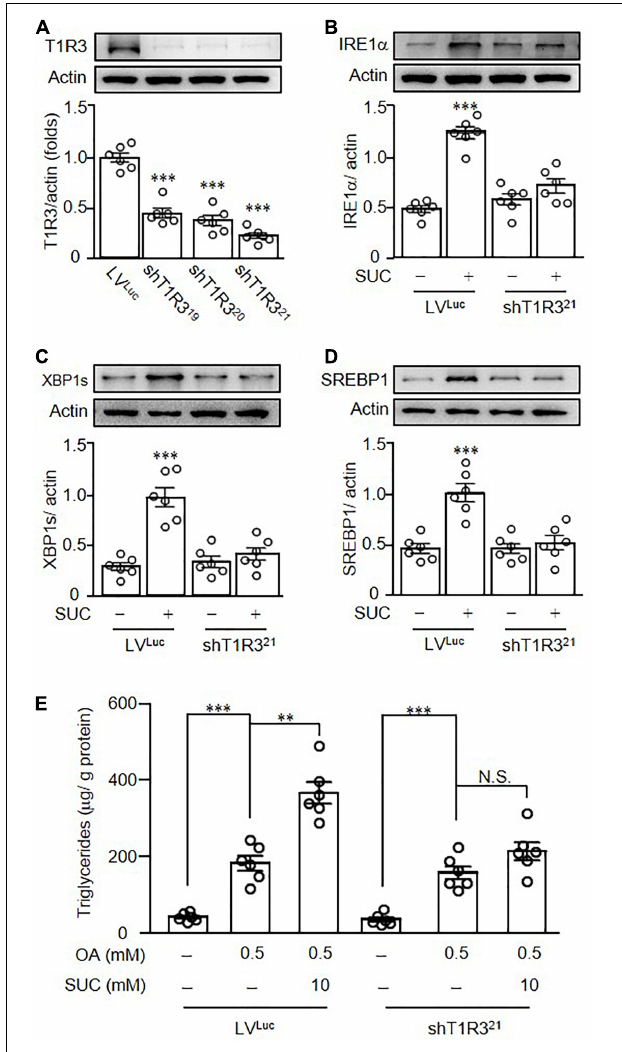
FIGURE 7 | Knockdown of T1R3 in HepG2 cells diminished the effects of sucralose on lipogenesis. Different clones of lentiviral vectors containing short hairpin RNA targeted to T1R3 (shT1R3) were used to evaluate the knockdown efficiency of T1R3 (A) . HepG2 cells transfected with lentiviral vectors containing luciferase (LV LUC ) or short hairpin RNA targeted to T1R3 (shT1R3 21 ) were treated with 10 mM sucralose (SUC) for 24 h to determine IRE1 α (B) , XBP1s (C) , and SREBP1 expressions (D) by Western blots. In addition, HepG2 cells transfected with lentiviral particles were pretreated with 10 mM sucralose for 24 h, and then treated with 0.5 mM oleic acid (OA) for another 24 h. Cells were harvested and the intracellular triglyceride contents